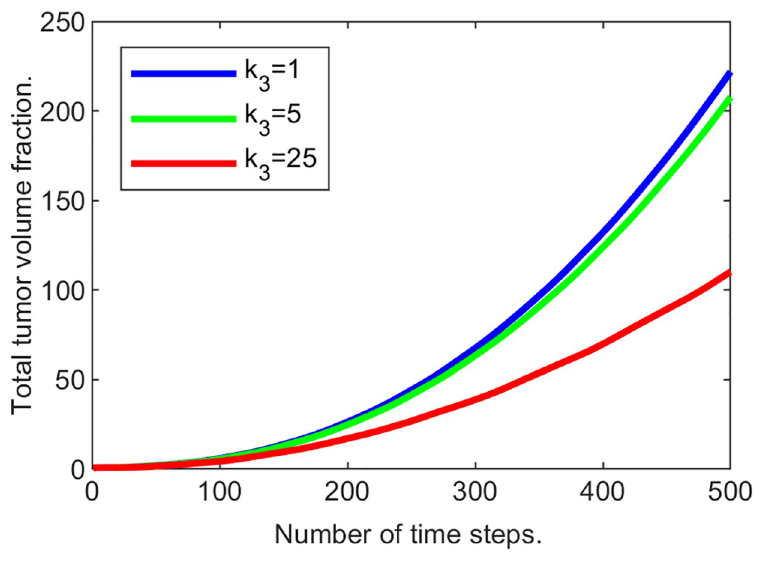
Fig 11. Tumor mass changing with time for various ECM strain-stress coefficients.